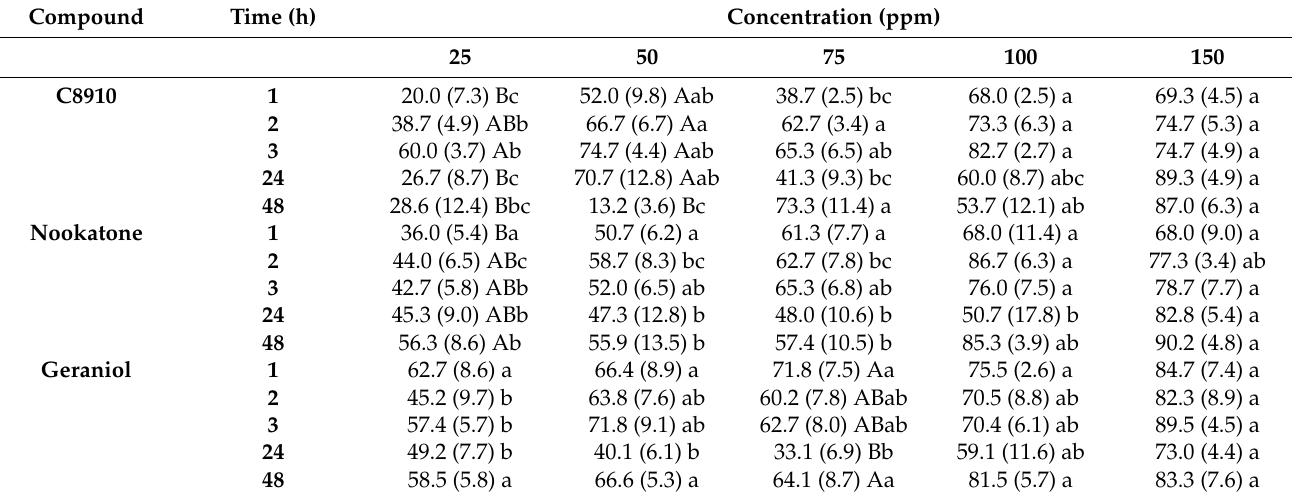
Table 2. Orientation of T. putrescentiae to dry-cured ham pieces coated with three different repellents vs. a water-control in laboratory two-choice bioassays. Mean repellency index, RI, ( ± SE; n = 5) of mites orienting over time to ham pieces treated with repellent solutions of different concentrations (ppm).